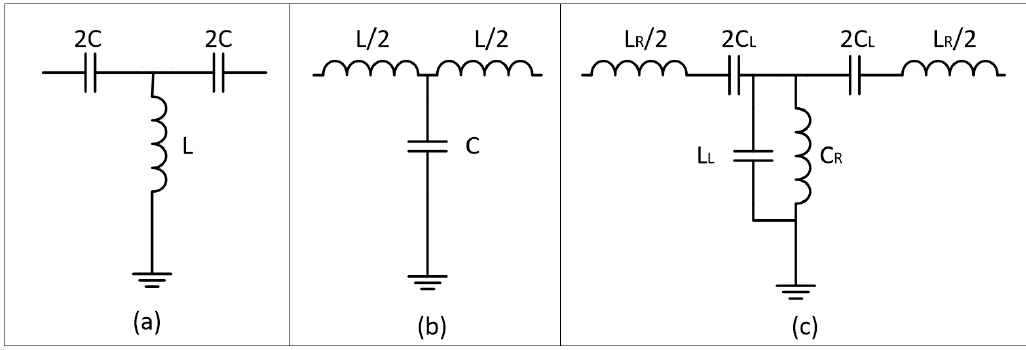
Figure 3 . ( a )Right-Hand (RH), ( b )Left-Hand (LH) and ( c )Composite Right-Left Hand (CRLH) Unit Figure 3. ( a ) Right-Hand (RH), ( b ) Left-Hand (LH) and ( c ) Composite Right-Left Hand (CRLH) Unit Cells. Cells—Adapted from Reference